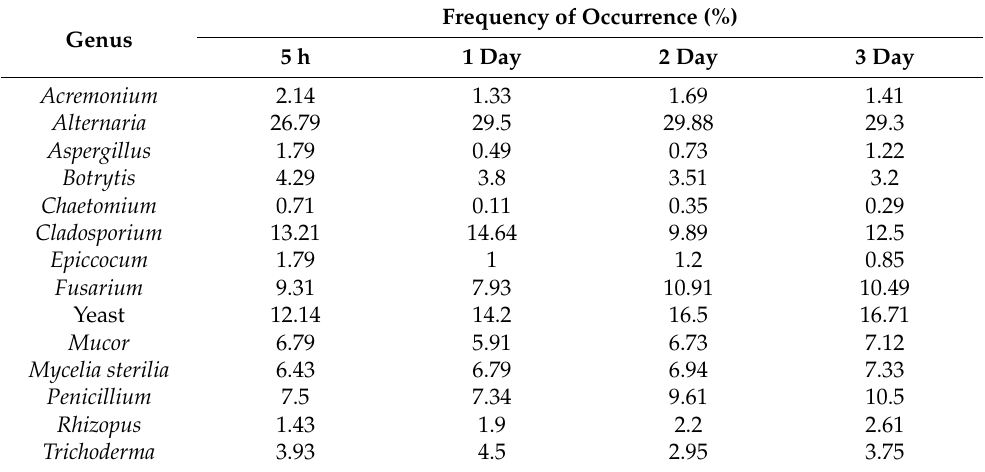
Table 2. Occurrence of fungi in bee